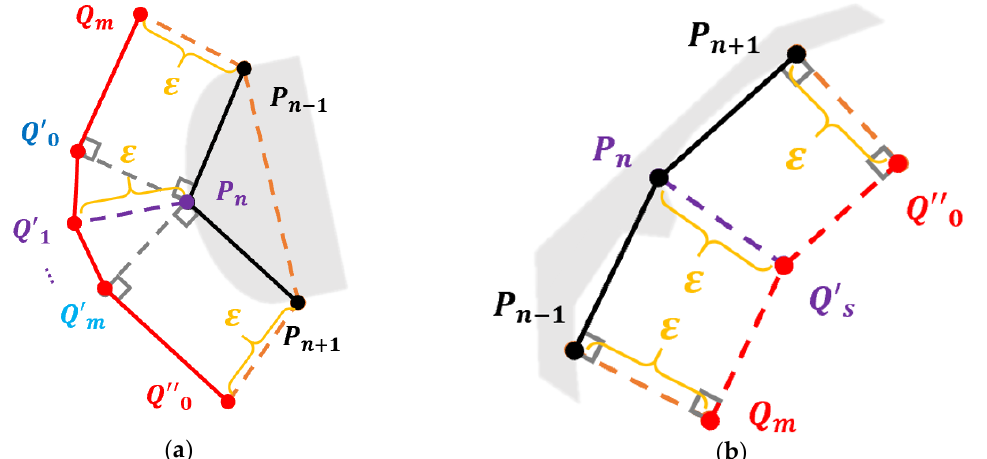
Figure 5. Circumscription of EDP: ( a ) Convex; ( b ) Concave.